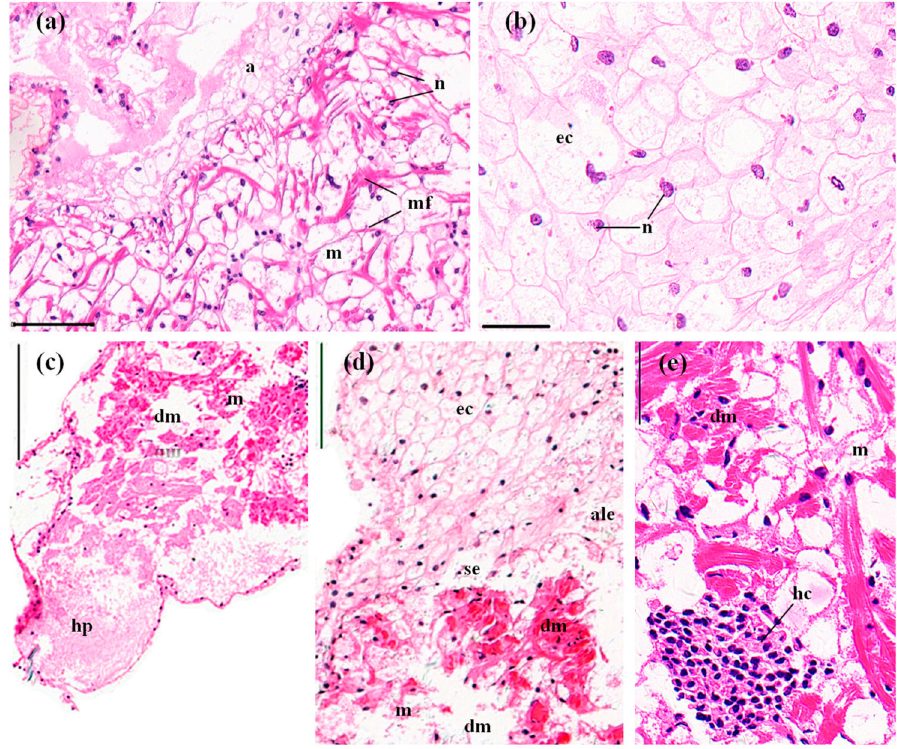
Figure 4. The hearts of P. clarkii after 96 h exposure to: a control solution ( a , b ); and 72.62 mg/L MBA ( c – e ). ( a ) Control tissues with normal structures of the myocardium (m) and adventitia (a). Note the multinucleated and branched myocardial fibers (mf) (200 × ). ( b ) Control adventitia tissues with uniform arrangement of the epithelial cells (ec). Note the netlike adventitia, the epithelial cells without cytoplasm, and the eccentrically located nuclei (n) (400 × ). ( c ) Damaged hearts exhibited hyperplasia of the epithelial tissue of the adventitia, and lysis and vacuolation in the myocardial fibers (dm) (100 × ). ( d ) Damaged hearts exhibited swelling, lysis and vacuolation in the myocardial fibers (dm), atrophy and lysis of the epithelial cells of the adventitia (ale), and slight separation of the adventitia from the myocardium (se). (200 × ). ( e ) Damaged hearts exhibited swelling of the myocardial fibers (dm) and hemocytic infiltration (hc) inside the myocardium (400 × ). myocardium (m); n, nuclei; ec, epithelial cell. H&E stain, scale bars = 100 µ